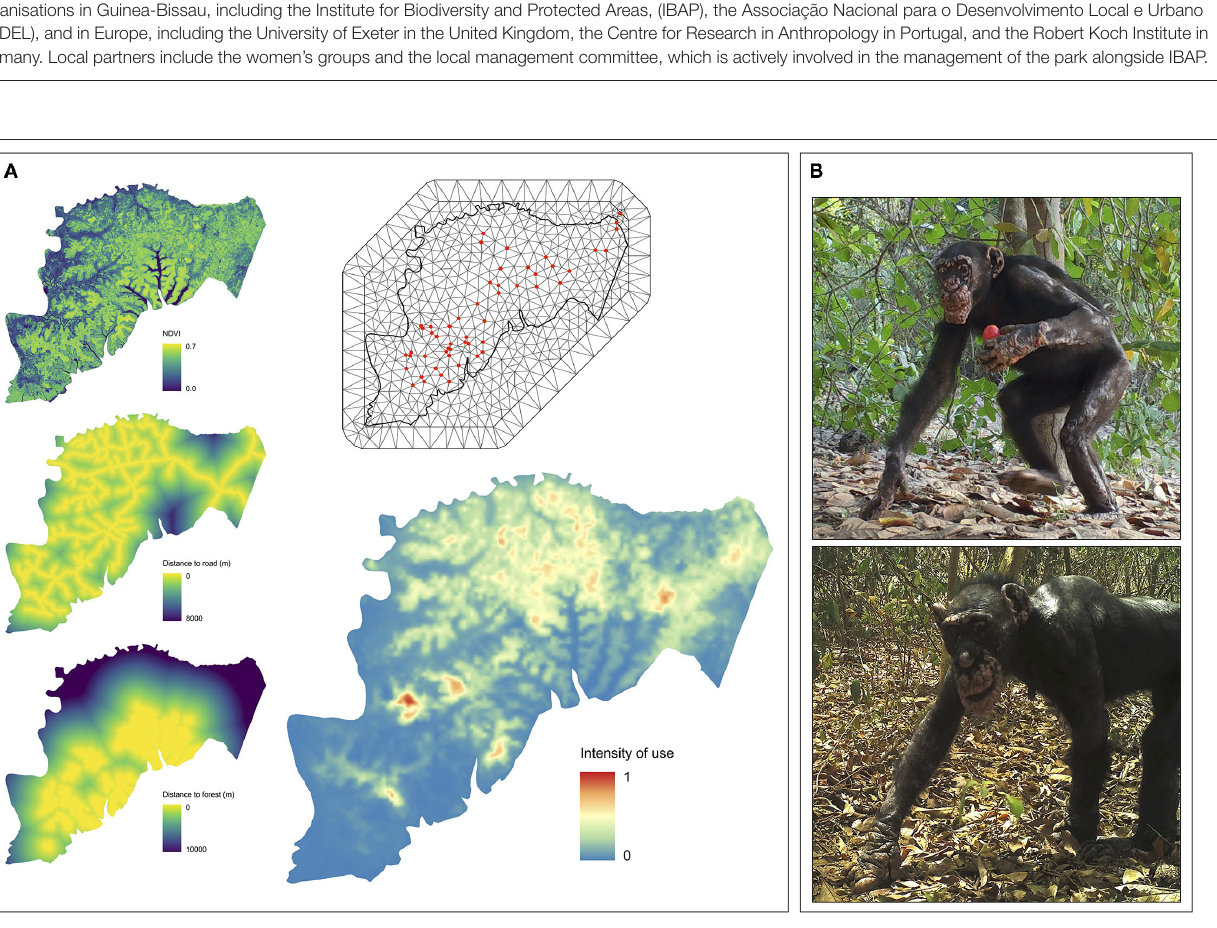
FIGURE 3 | Summary of results based on camera trap data from the first season of the biodiversity monitoring programme in Cantanhez NP. (A) Camera trap data were analysed to determine intensity of space use by chimpanzees. We employed Bayesian spatial modelling using the Integrated Nested Laplace Approximation (INLA) with Stochastic Partial Differential Equation (SPDE) approach (Lindgren et al., 2011; Rue et al., 2009) using the R-INLA package on R (Blangiardo et al., 2013; Blangiardo and Cameletti, 2015; R Core Team, 2020). Since its recent inception, this efficient statistical framework has become established across various scientific disciplines (Rue et al., 2017; Bakka et al., 2018) including wildlife ecology (e.g., Lezama-Ochoa et al., 2020). Its applicability to camera trap-based ecological research has also been recently demonstrated (Bersacola et al., 2021). Our model included seven covariates, including normalised difference vegetation index (NDVI), calculated from Sentinel-2 imagery dated 29 February 2020, as well as linear distance to the nearest protected forest block, distance to the nearest village, distance to large roads (newly improved 10 m-wide gravel roads) and distance to all roads (including small rural roads). Latitude and longitude were also included as covariates. This modelling framework uses a triangulation mesh of the study area to estimate the spatial autocorrelation amongst the sampling points and allows for the estimation of geostatistical data across a continuous field (interpolation). Bottom right shows the output map of the selected Binomial-SPDE model for chimpanzees, with the response variable constituting intensity of space use by chimpanzees at Cantanhez NP, represented by the sum of the number of occasions with positive detection (y) relative to the total number of sampling occasions (number of trials). (B) Two of the identified advanced leprosy cases in chimpanzees in Cantanhez NP, from top to bottom showing “Rita”, an adult female from the Caiquene-Cadique community diagnosed with advanced leprosy based on camera trap footage and confirmed through molecular analysis in her chimpanzee community, and “Cristina”, an adult female from the Faro Sadjuma community, with her diagnosis based on physical